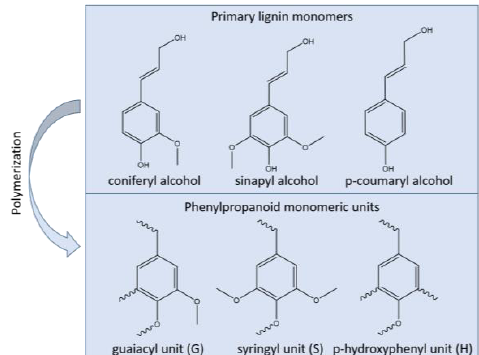
Figure 2. Primary lignin monomers are hydroxycinnamyl alcohols which are known as monolignols. These primary lignin monomers are polymerized. The corresponding phenylpropanoid monomeric units in the lignin polymer are guiacyl units (G), syringyl units (S), and p-hydroxyphenyl units (H), respectively, which can be polymerized at any of the wavy bond positions [12,13].